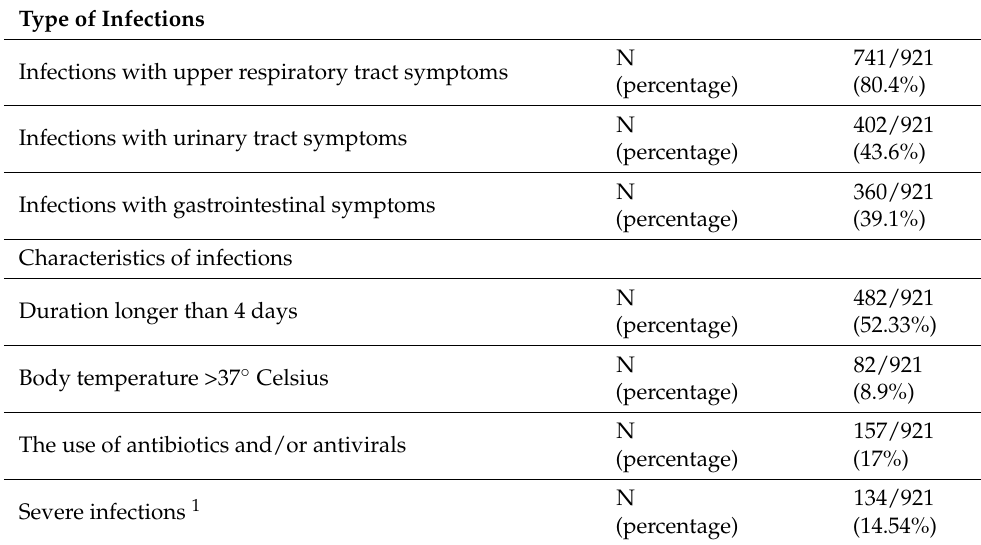
Table 3. The proportion of type and severity of infections according to symptom